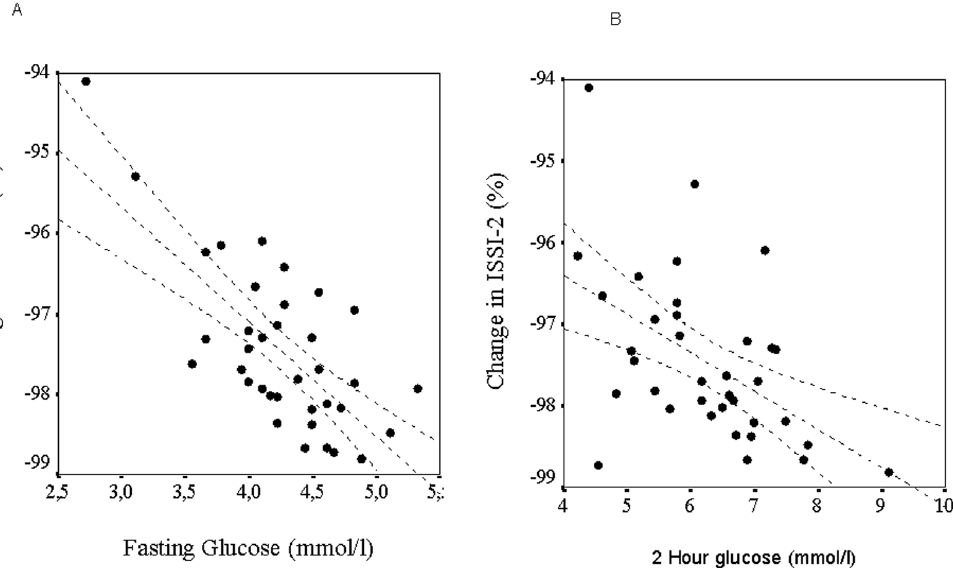
Figure 3. Relationship between percent changes over follow-up in the Insulin Secretion-Sensitivity Index 2 (ISSI-2), the oral glucose disposition index, and serum concentrations of fasting (Panel A; y= 2 5.8962x–497.65; p , 0.0001; R 2 =0.492) and 2 hour serum glucose (Panel B; y= 2 11.207x–979.11; p , 0.0001; R 2 =0.294) in school-age children. The decrease of the glucose disposition index over the follow-up period was associated with higher values of fasting and 2 h glucose in school-age children. doi:10.1371/journal.pone.0068628.g003 PLOS ONE |